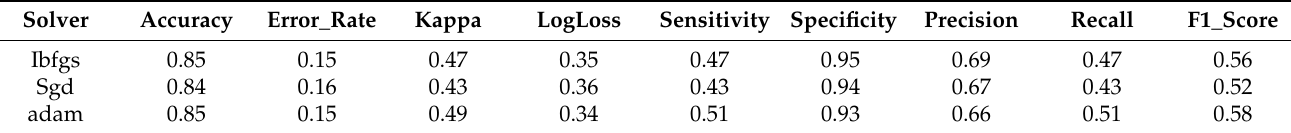
Table 11. Metrics for solver parameter.